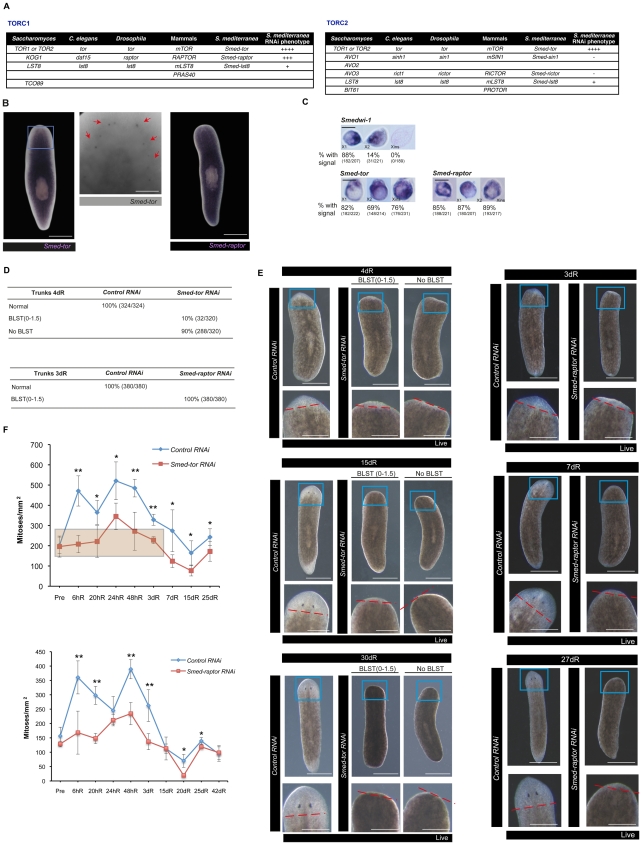

Smed-tor and Smed-raptor are necessary for the response to injury and blastema growth.A. Tables that summarise the components of mTORC1 and mTORC2 found in S. mediterranea. +++ indicates strong phenotype, ++ indicates weak phenotype, + indicates very weak phenotype, − indicates no phenotype after RNAi experiments. B. Smed-tor and Smed-raptor are broadly expressed in the planarian body. A high magnification of the head region (blue square) shows that Smed-tor is also expressed in a subset of neurons in the brain ganglia (red arrows) (n = 30/30 in three independent experiments). C. ISH on FACS-isolated cells. Representative results are shown. Percentages are signal-positive cells. Smedwi-1 was used as a positive control and neoblast marker. Smed-tor and Smed-raptor are expressed in all three populations. D. Table that summarises the phenotypes observed in trunks at 4 dR for Smed-tor and 3 dR for Smed-raptor. BLST indicates blastema. Phenotype classification is according to previous published data [63]. E. Panels show representative planarians at different times of regeneration. Smed-tor(RNAi) planarians either show a small blastema (the biggest blastema observed is shown (BLST(0–1.5) or no blastema at all. Smed-raptor(RNAi) show smaller blastemas than controls (the biggest blastema observed is shown (BLST(0–1.5). The blastema does not grow further during regeneration, compared to controls. Planarians never showed signs of ventral curling or regression, typical features observed when abrogating genes expressed in neoblasts [22], [24] and were never depleted of neoblasts. The blue square represents the area of high magnification. The dotted red line defines the blastema. F. Mitotic numbers during different time points of regeneration and representative images showing H3P staining. Error bars are s.d from the mean and asterisks indicate P<0.05 (one asterisk) or P<0.01 (two asterisks) using two-tailed Student's test with equal sample variance (n≥5 planarians per time point in at least two independent experiments). Scale bars indicate 300 µm in B, 50 µm in B high magnification, 10 µm in the isolated cells in C, 300 µm in E and 150 µm in the E high magnifications.